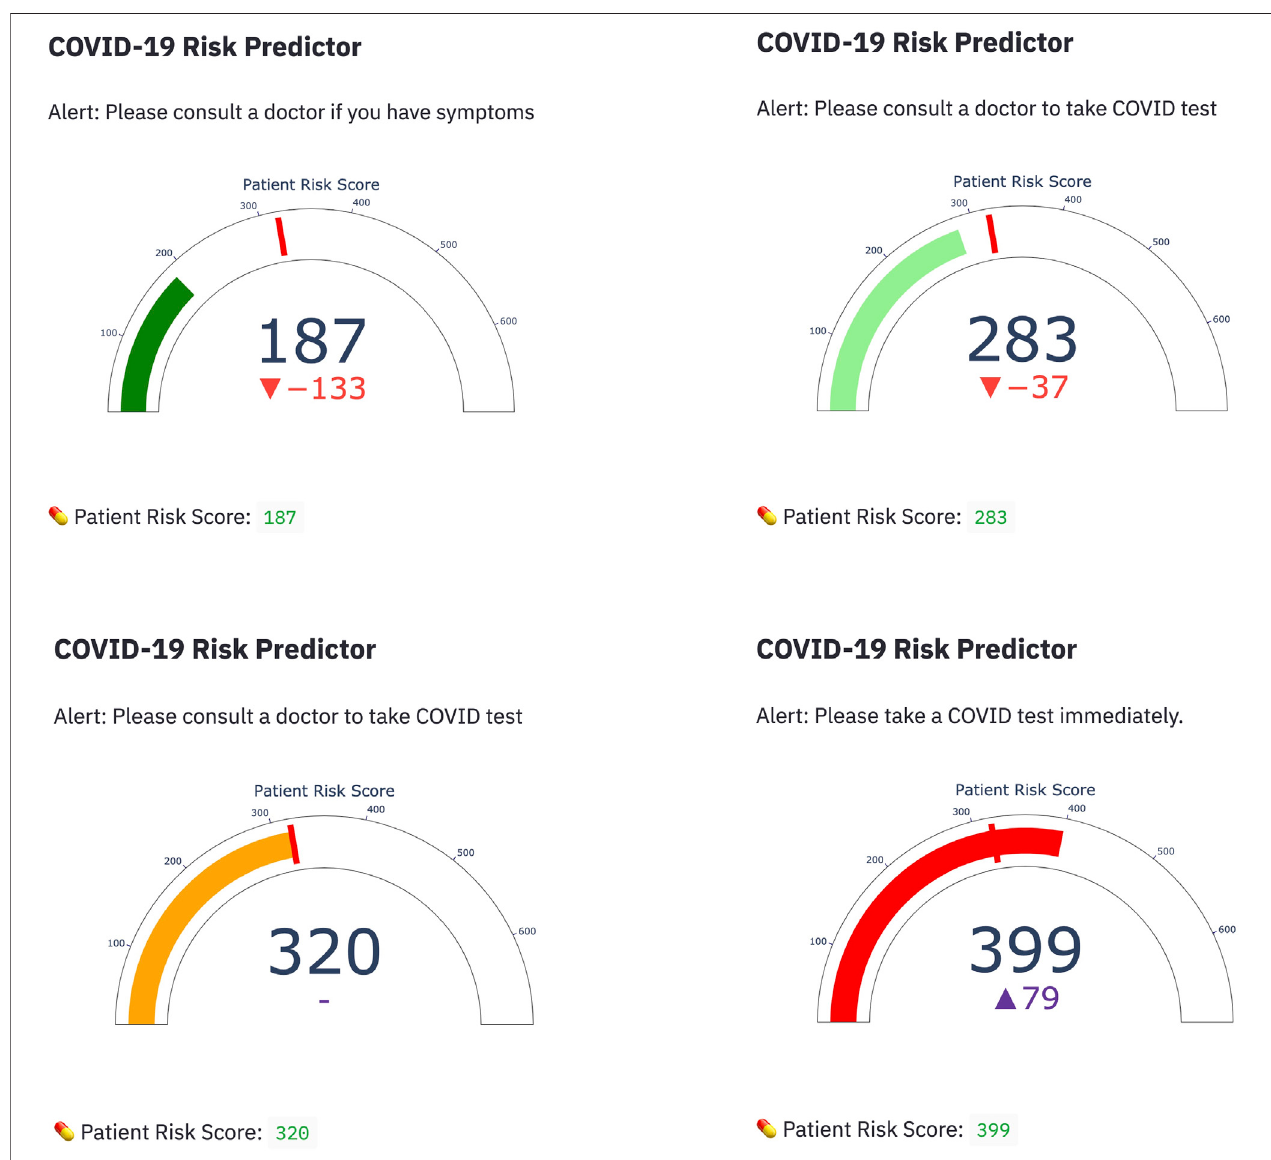
FIGURE 4 | Web application demonstration Four representative snapshots with different scorings from the COVID-19 risk predictor web application are shown. Scores were calculated based on participant answers to questions related to their symptoms and conditions using the Credit Scorecard method.